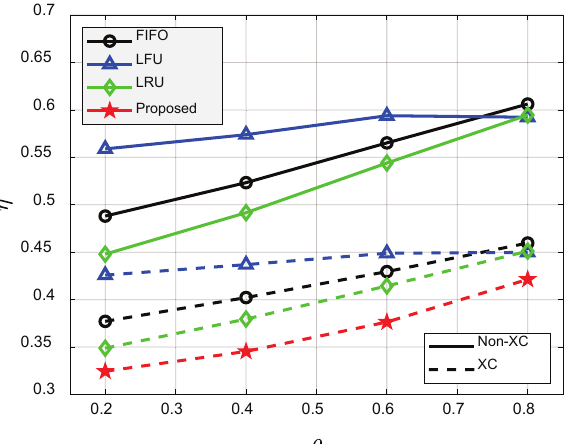
Figure 6. Average number of required transmissions for various ρ ’s. p = 0.001, V = 100, N = 50, C = 20, K = 10, and β = 1.